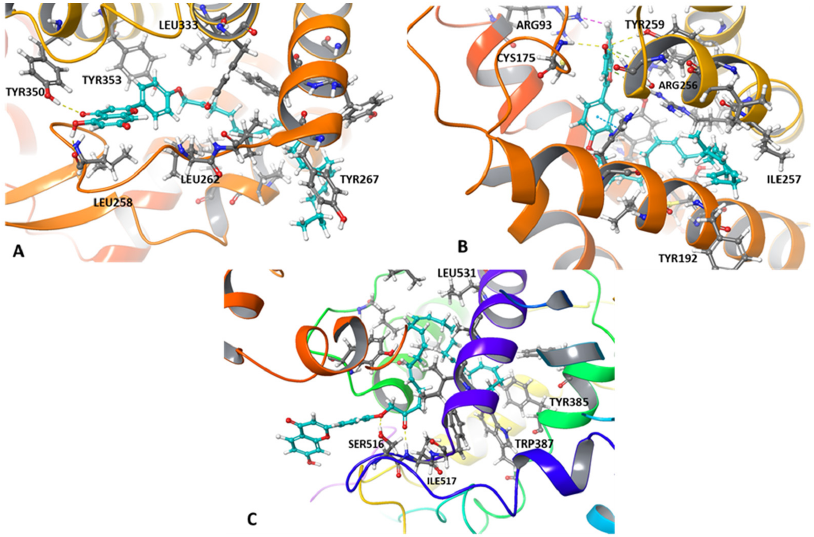
Figure 2. Most favorable docked poses of 4 ′ -DHA-apigenin in the three receptors and their hydro- gen and pi interactions ( A ) PAR-1, ( B ) P2Y12, and ( C )